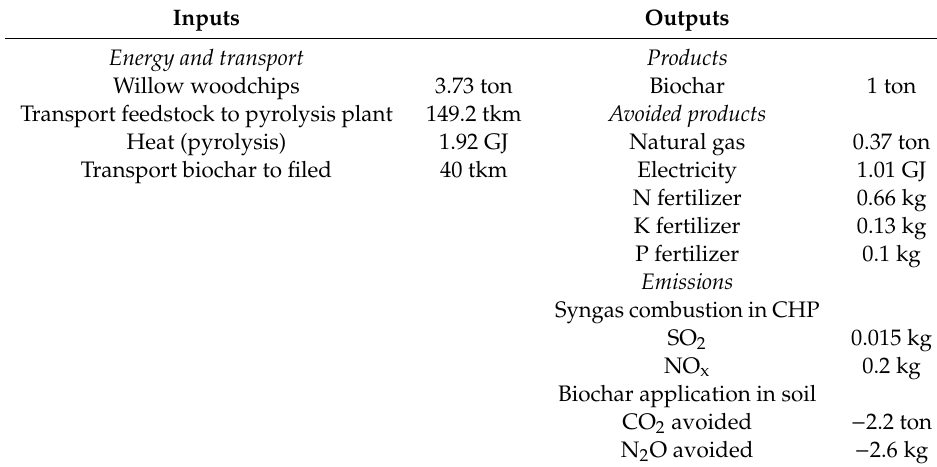
Table 1. Inventory data for 1 ton of biochar obtained via willow